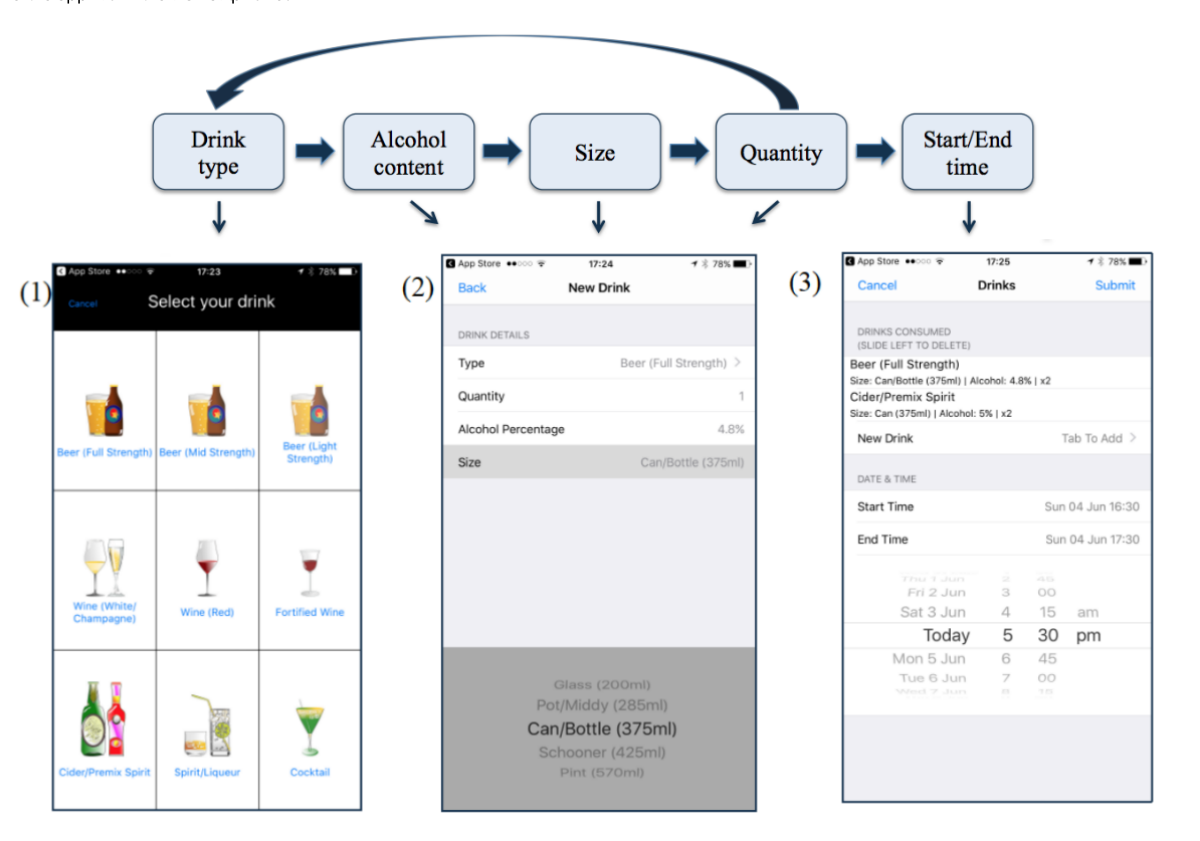
Figure 1. Flowchart of assessment pathway and screenshots from the CNLab-A app. On opening, CNLab-A asks users if alcohol has been consumed in the last 24 hours. Thereafter, participants are asked if they have consumed alcohol since their last submission. If they indicate (by pressing “No”) that no drinking has occurred, the app can be closed. If participants indicate drinking has occurred (by pressing “Yes”), images of common alcoholic beverages (including beer, wine, cider/premix, spirit/liqueur, and cocktail) are displayed (1). Type of beverage consumed is selected by touching the appropriate image on the screen. Quantity and size consumed for each beverage is indicated via a simple scroll option menu (2). Alcohol content as a function of beverage type is prefilled. This process is repeated by tapping “Back” in order to add as many drink types as required. Erroneously entered data can be deleted by swiping left. Prior to submitting data, the start and end time of drinking must be specified, again using a scroll option menu (3). Participants are able to either report drinking in separate sessions or they can leave the app open so as to record beverages as they are consumed. The latter option still allows participants to use other features on their phone. Participants can access a history of their submission dates and times (but not their drinking data) via the “History” button. At the conclusion of the experimental period, an automated message thanks participants; gives them simple feedback regarding the number of days they consumed alcohol, total standard drinks consumed, and average daily consumption; and, asks them to remove the app from their